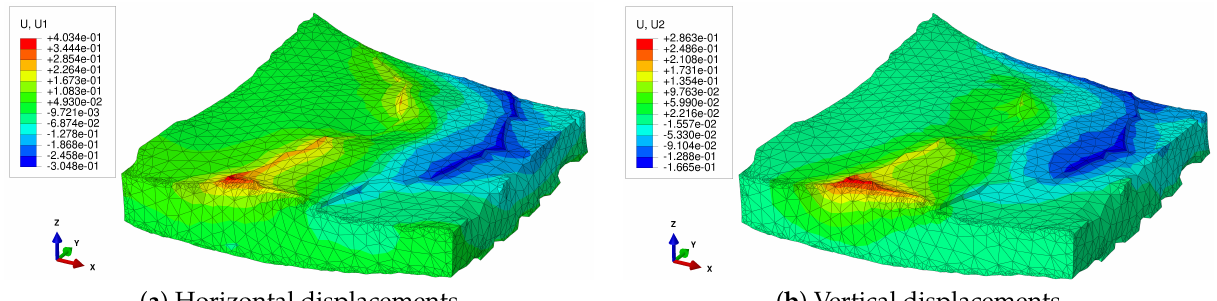
Figure 8. Maximum horizontal and vertical displacements for the Retina and ERM model—Non- Recovered Patient,